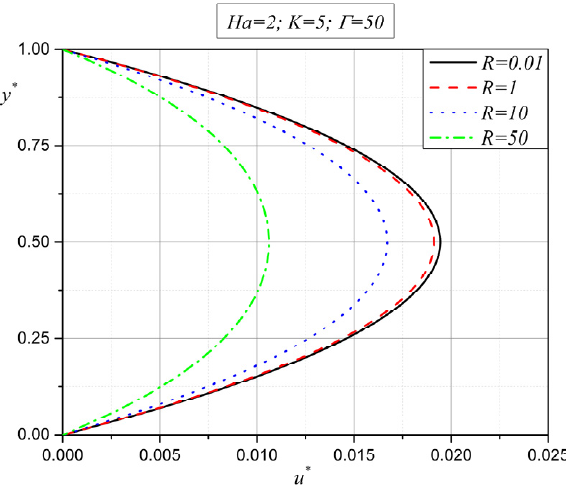
Figure 13. Velocity profiles u * for different values of porosity parameter R .